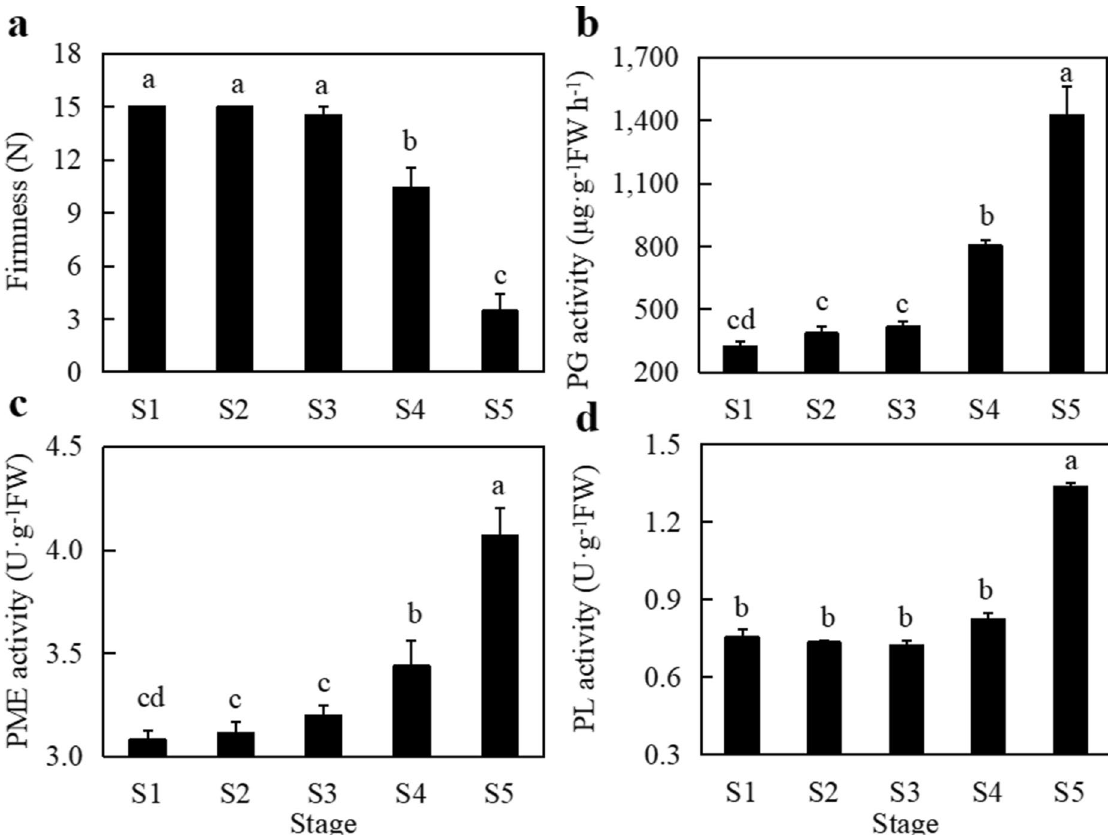
Figure 3. Numbers of RNA-seq transcriptome reads in different length intervals.Changes in fruit firmness in different developmental and mature stages (a); polygalacturonase activity; PG activity (b); pectin methyl esterase activity; PME activity (c); pectin lyase activity; PL activity (d). Different letters indicate significant differences at P < 0.05.